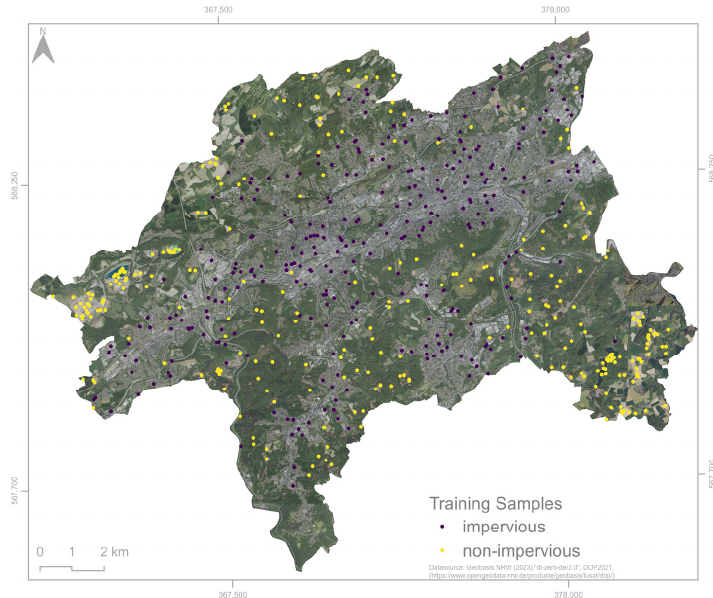
Figure 4. Distribution of generated training samples in the study area.